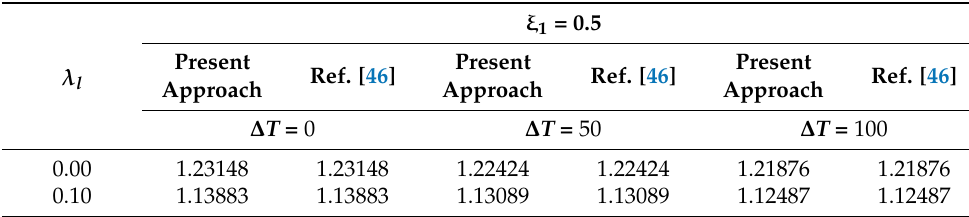
Table 4. Linear dimensionless natural frequencies of porous FG clamped–clamped (C–C) nano-beam ( A w = 0, λ c = 0.20, ξ 1 = 0.5).